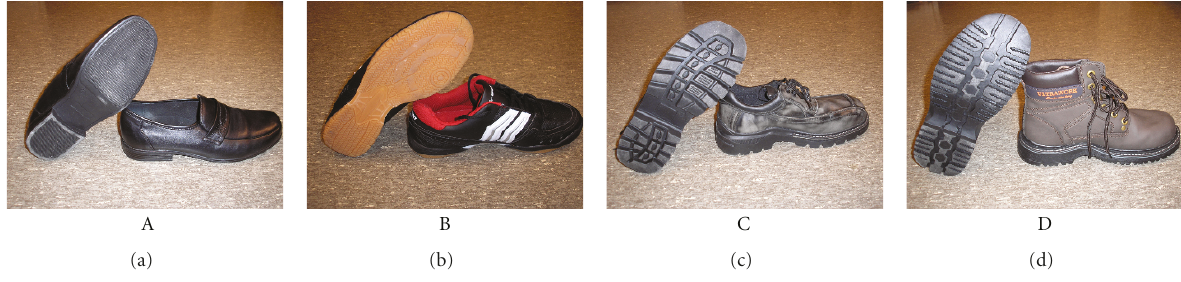
Figure 8: The footwear types A, B, C, and